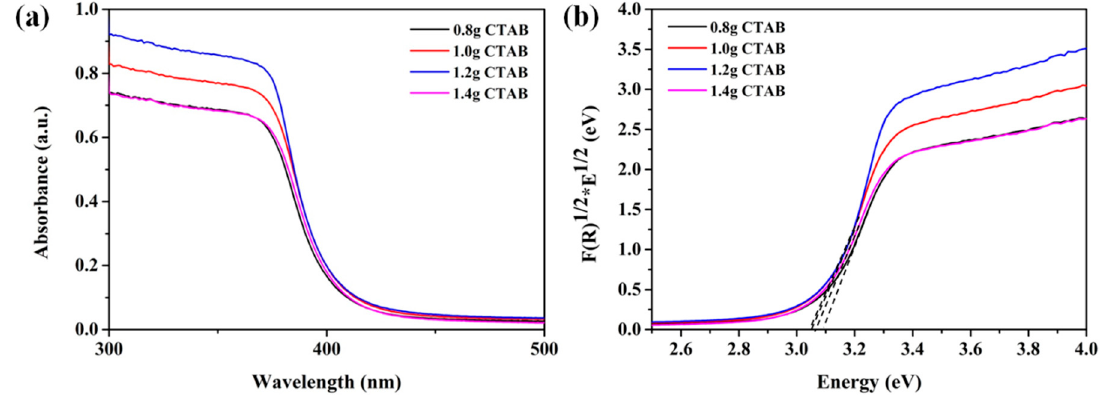
Figure 6. ( a ) UV-vis absorption spectra of ZnO synthesized with different amounts of CTAB and ( b ) tauc plot.